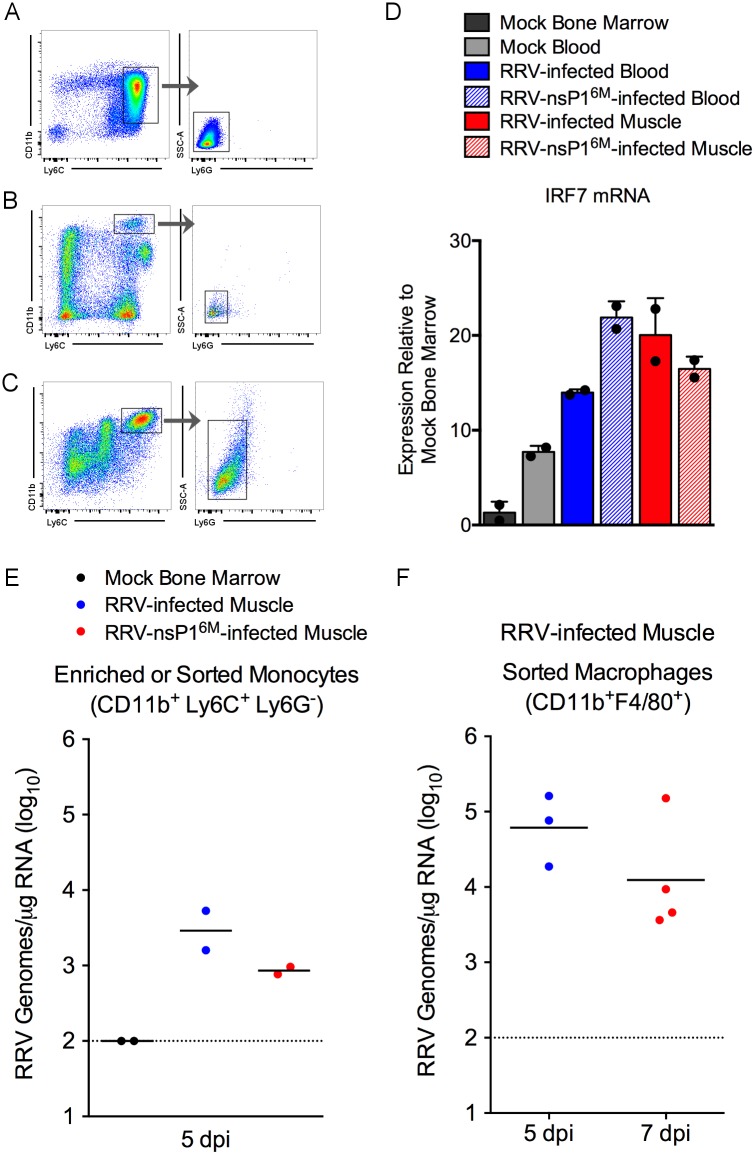
Inflammatory monocytes express Irf7 and are viral RNA-positive during RRV infection in vivo.WT C57BL/6 mice were inoculated in the left rear footpad with PBS or 1,000 PFU of RRV-T48 or RRV-T48-nsP16M. At 5 dpi, Ly6Chi monocytes were enriched from the bone marrow or FACS-sorted from the blood and from enzymatically-digested muscle tissue. (A-C) Representative flow cytometry gating of cells sorted from the (A) bone marrow, (B) blood of RRV-infected mice, and (C) skeletal muscle of RRV-infected mice. (D) Irf7 mRNA expression levels in enriched cell populations were quantified by qRT-PCR. Data are normalized to 18S rRNA levels and are expressed as the relative expression (n-fold increase) over expression in Ly6Chi bone marrow monocytes from uninfected mice. Each data point represents monocytes sorted from the combined tissues of 3 mice. Each bar represents the arithmetic mean of two independent experiments. (E-F) RRV RNA levels in enriched monocyte/macrophage populations sorted from bone marrow of uninfected mice or skeletal muscle tissue of RRV-infected mice were quantified by qRT-PCR. (E) Each data point represents monocytes sorted from the combined muscle tissues of 3 mice. (F) Each data point represents monocytes/macrophages sorted from the muscle tissue of 2 mice (5 dpi) or a single mouse (7 dpi).